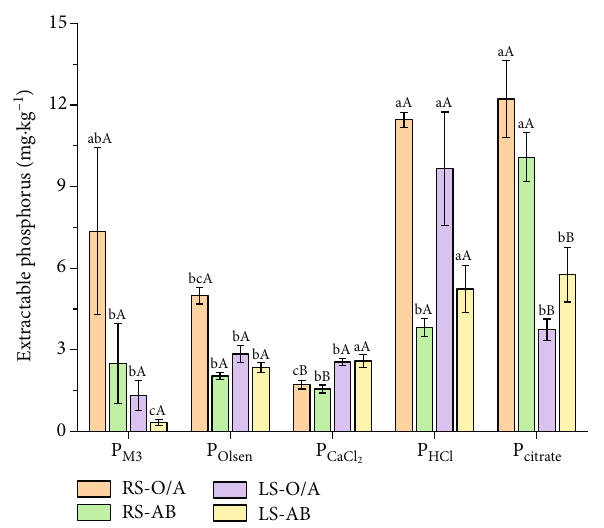
Figure 3: Degree of P saturation in the O/A horizon and the AB horizon of red soil (RS) and limestone soil (LS). Di ff erent lowercase letters indicate signi fi cant di ff erences ( p < 0 : 05 ) between the same soil horizon of the red and limestone soil. Error bars are standard error ( n = 3